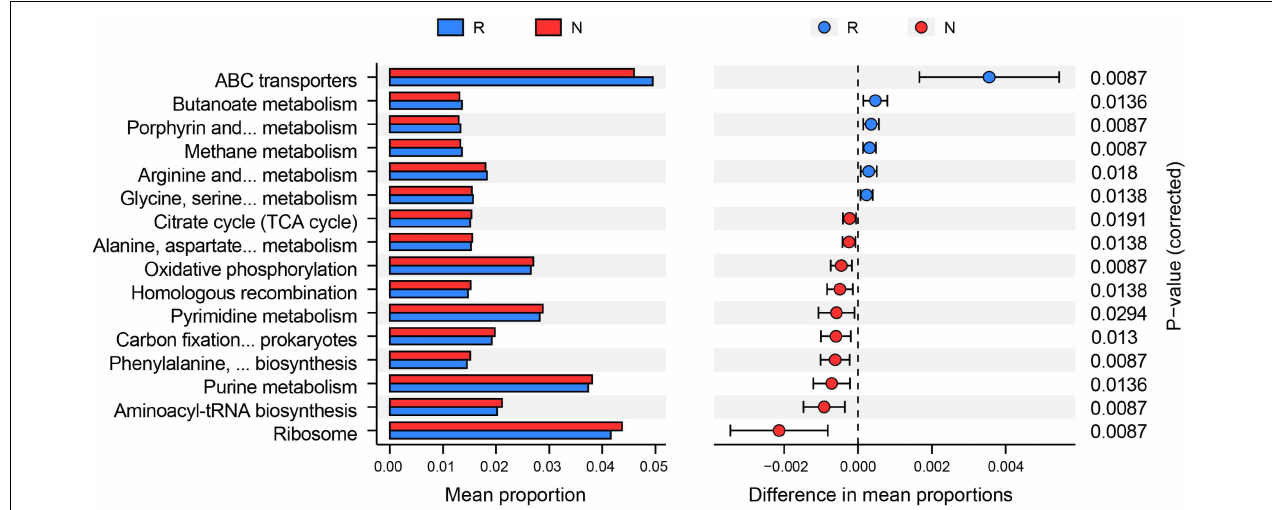
FIGURE 5 | Functions of bacterial community based on Kyoto Encyclopedia of Genes and Genomes (KEGG) analysis. PICRUST2 predicted the alterations of the KEGG pathway between rhizosphere (R) and bulk soil (N) (adjusted p < 0.05). The mean proportion of the KEGG function was calculated to indicate relative abundance in the two groups. TABLE 1 | The relationships of bacterial community diversity with soil properties based on Spearman rank correlation analysis. Rhizosphere Bulk soil Shannon